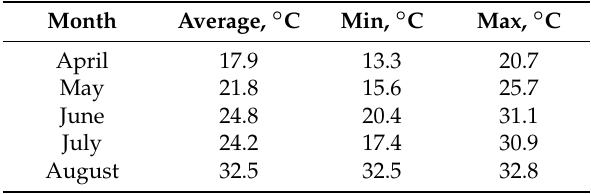
Table 1. The average, minimum and maximum temperatures in each month measured inside a greenhouse.